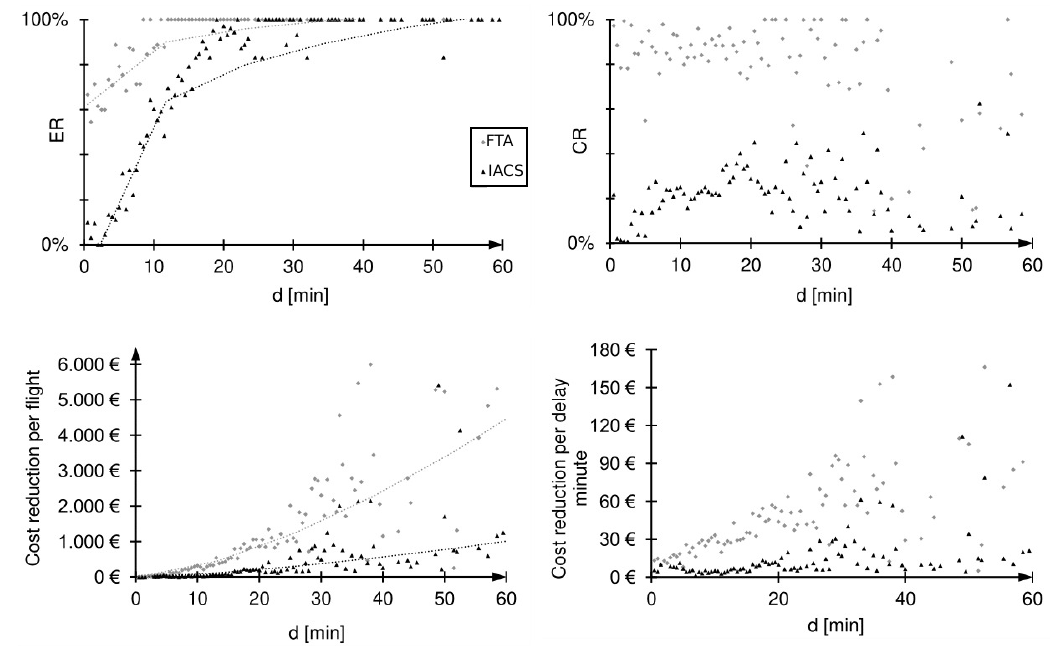
Figure 9. Comparison of success rate ER ( top left ) , compensation rate CR ( top right ), cost reduction per flight ( bottom left ) and cost reduction per delay minute ( bottom right ) of the most effective delay costs compensation strategies: Fast turnaround (FTA, grey) and increased cruise speed (IACS,